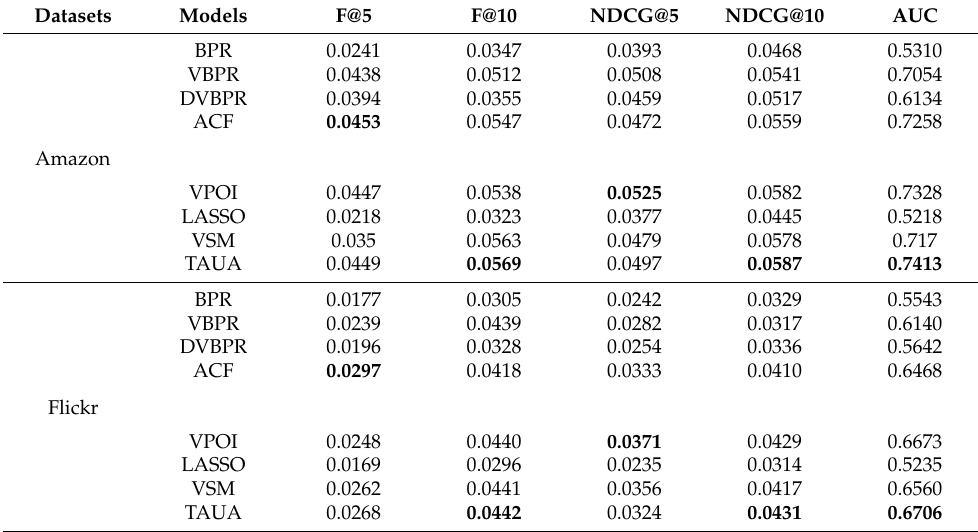
Table 8. Algorithm performance